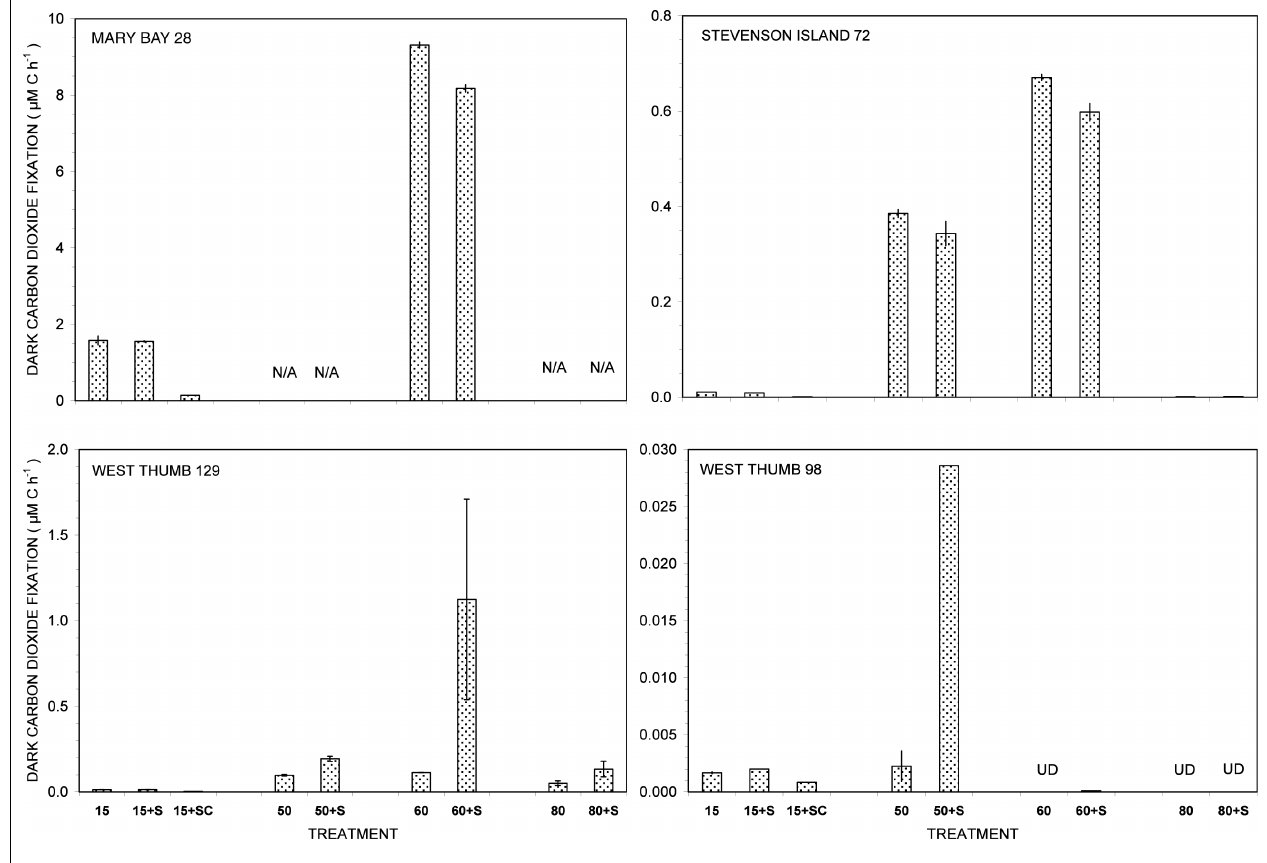
thiosulfate. Biological fixation controls with added S + 20 μ g/mL chloramphenicol (SC) were tested at 15˚C only. UD, undetectable ( < 0.0005 μ MCh − 1 ); N/A, not